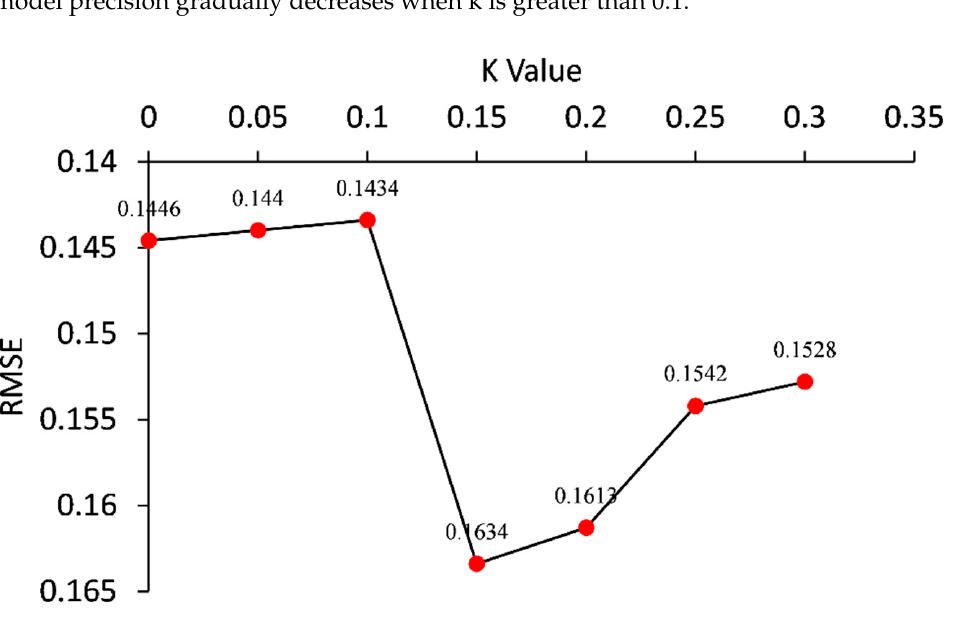
Table 2. Details of parameter values corresponding to different k values.